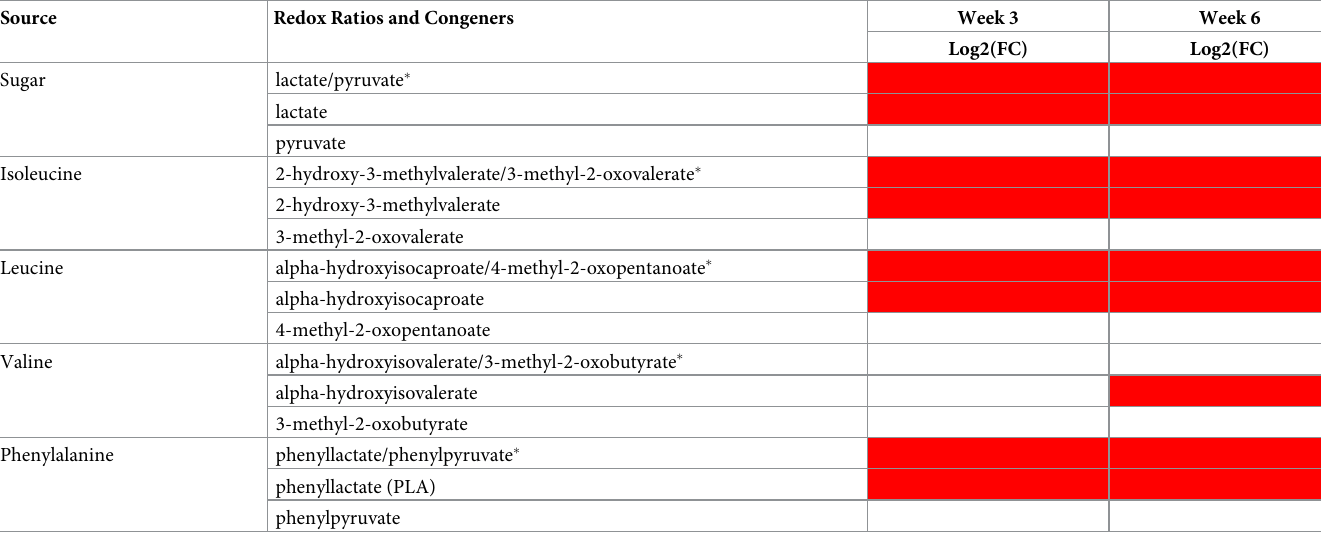
Table 8. Redox-coupled congeners detected via metabolomic screening in fecal samples taken at weeks 3 and 6 from cats fed LRS or HRS